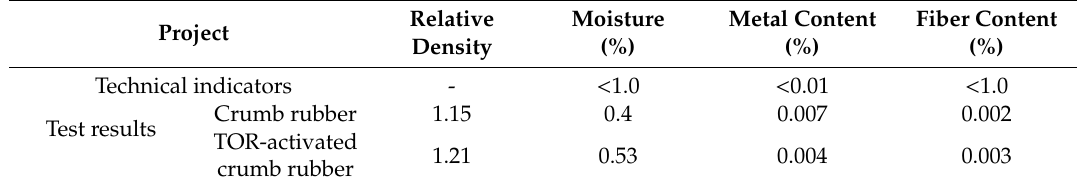
Table 2. Properties of crumb rubber (CR) and TOR-activated crumb